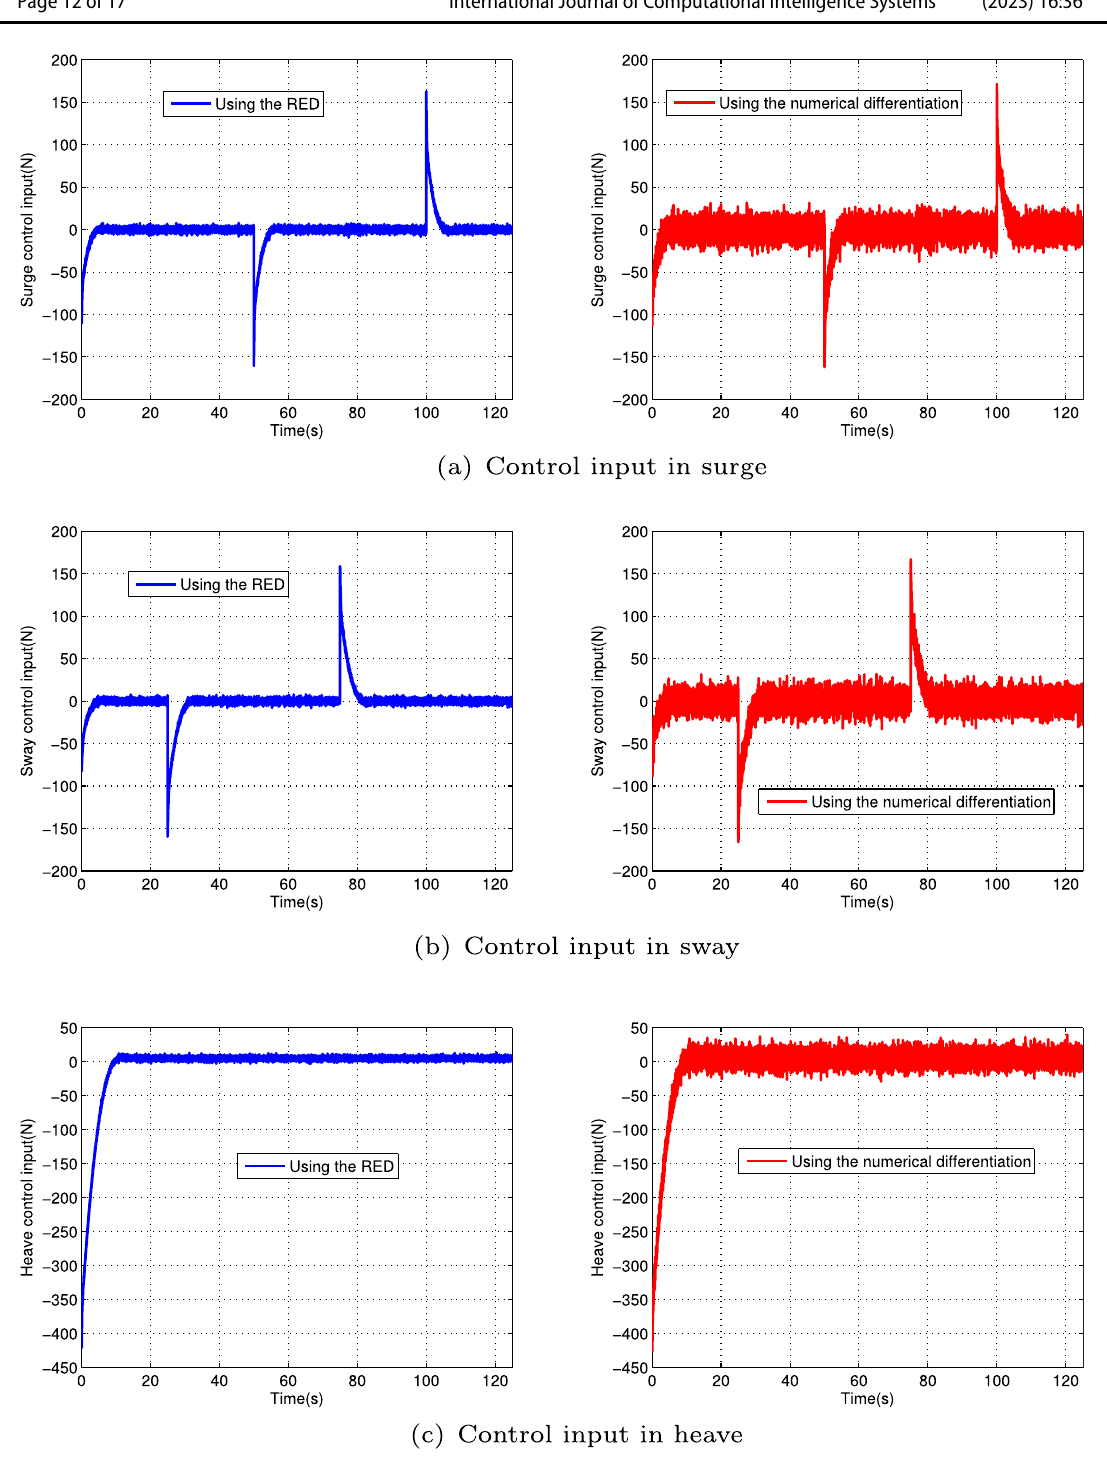
Fig. 7 The control input of proposed controller using RED against numerical differentiation method under measurement noise 𝜻 ( t ) and measure- d ( t ) = 0.723sin ( t ) ment delay